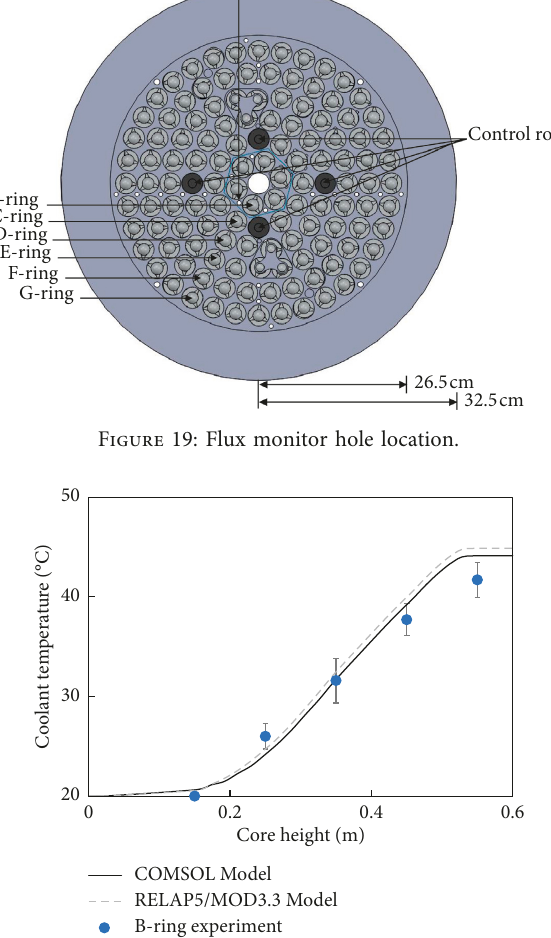
Figure 20: Comparison of the measured and predicted coolant temperatures versus the core